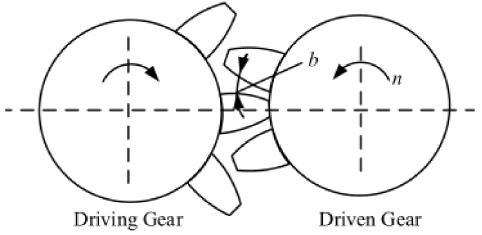
Figure 2. The schematic diagram of gear structure and motion relation.